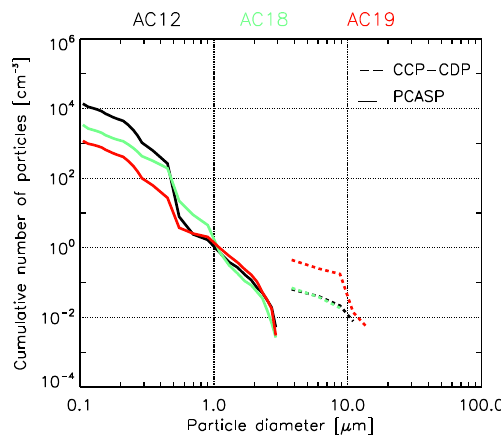
Figure 10. Cumulative aerosol size distribution below cloud base calculated from the PCASP probe for typical clean, polluted, and very polluted regions (solid line) for flights AC12 (very polluted), AC18 (polluted), and AC19 (clean). Similar for cumulative cloud droplet size distribution calculated with CCP–CDP (dashed line). The flight numbers are indicated by colors at the top of the panel.